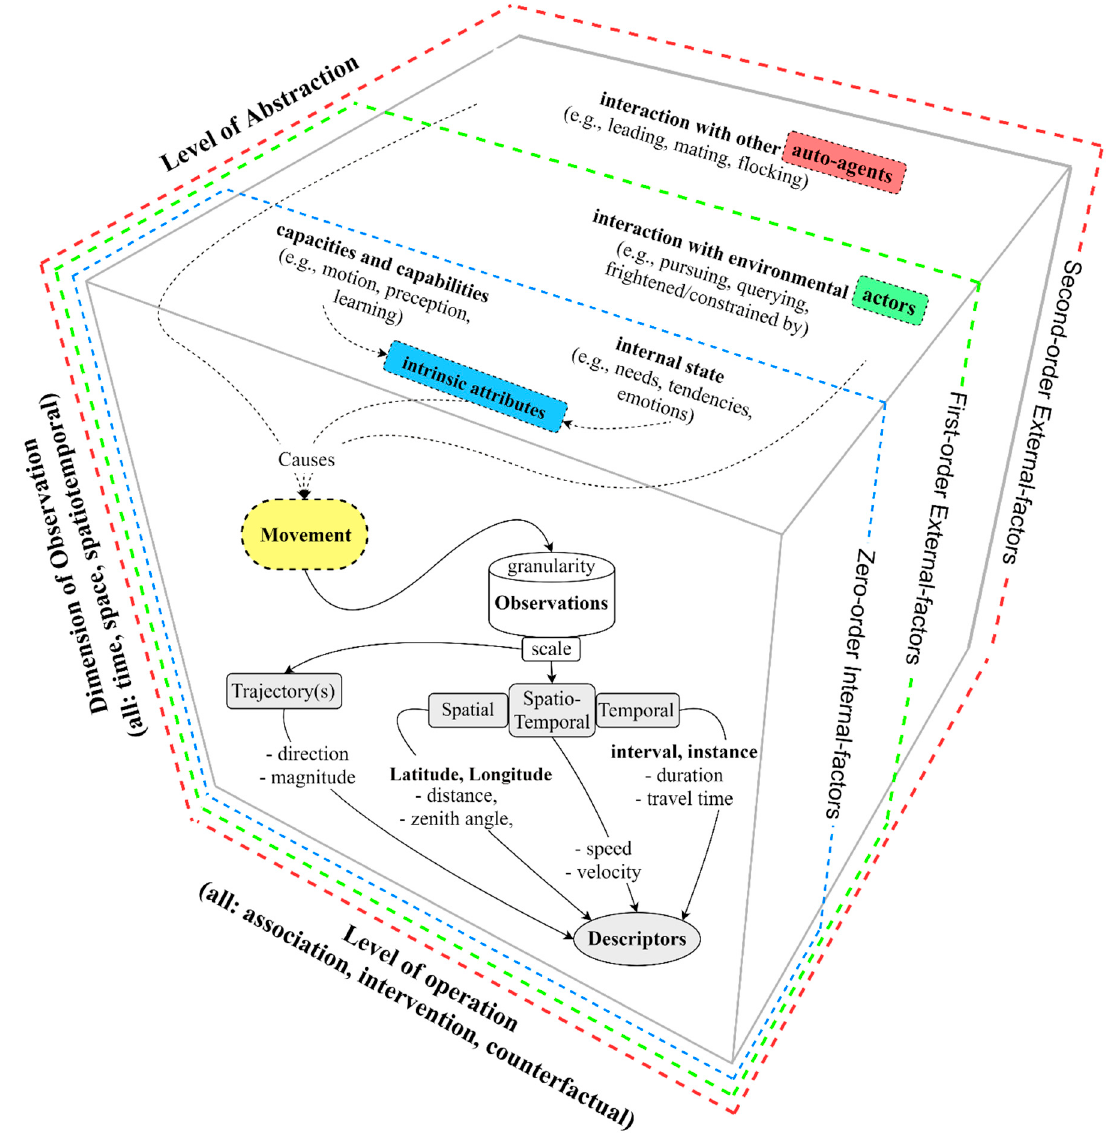
Figure 4. The key movement analysis concepts interpreted in causal language, mapped to the Figure 3 conceptual cube. Three sets of causes of movement operate at three different levels of abstraction: categorised as zero-order (intrinsic attributes), first-order (interaction with environmental actors), and second-order (interaction with other auto-agents) factors. This figure illustrates that movement studies could analyse the effect of each causal factor across various dimensions (spatial, temporal, spatiotemporal, and trajectory-based movement descriptors) and levels of operation (association, intervention, counterfactual).